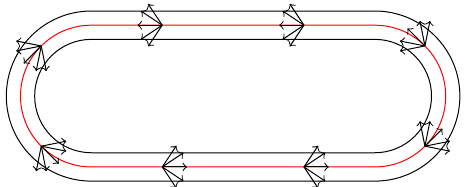
Figure 4. [11] Basic form of the track. The red line shows the 1D simplification. The arrows show the possible heading